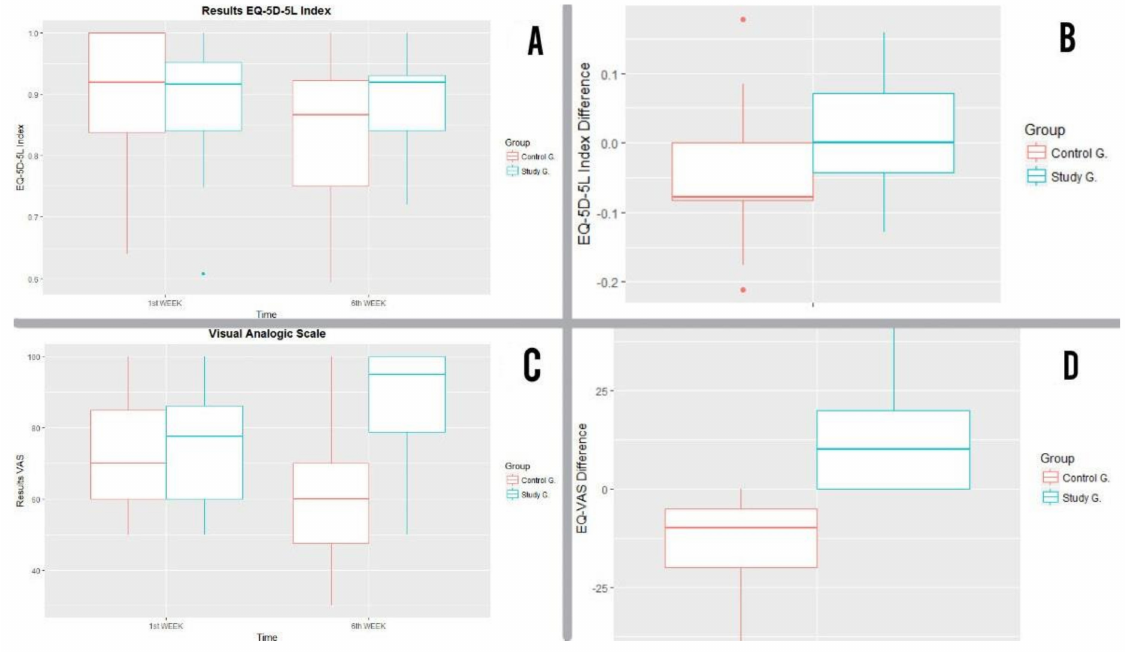
Figure 8. ( A ) Results obtained from the EQ-5D-5L Index in week 1 and week 6 for control and study groups. ( B ) Results of EQ-5D-5L Index differences in week 1 and week 6 for control and study groups. ( C ) Results of EQ-VAS in week 1 and week 6 for control and study groups. ( D ) Result of EQ-5D-5L Index differences in week 1 and week 6 for control and study